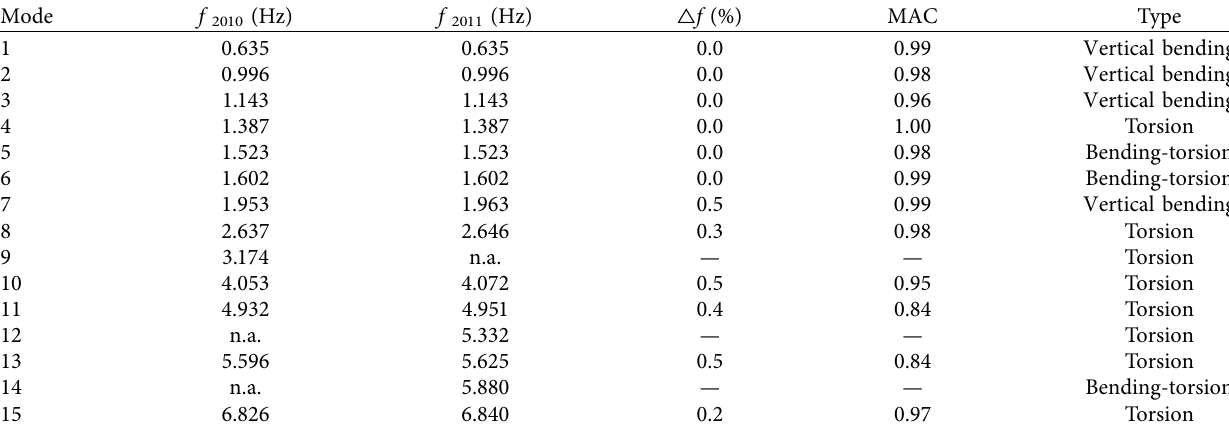
Figure 11: The measurement nodes on top of the bridge deck and on the tower (units in meter). Table 5: Comparison of the experimental modal data between 2010 and